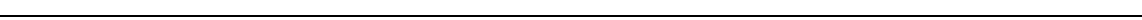
Fig. 5 iNKT cells suppress arthritis. a Representative fl ow cytometry plots of iNKT cells (TCR β int CD1d- α GC tetramer + in live CD8 − CD19 − cells), in ankles of SKG mice during the course of arthritis. Day 0 (circle), day 12 (square), day 22 (triangle), and day 47 (diamond) post-mannan injection. b Number of iNKT cells in ankles (left panel) and correlation with ankle swelling (right panel) during the course of arthritis in SKG mice. c Expression of CD69 on ankle iNKT cells during the course of arthritis in SKG mice. d Clinical score (left panel) and change in ankle thickness (right panel) in Cd1d − / − ( n = 6) and Cd1d + / − ( n = 8) male SKG mice after injection of mannan. e Histological evaluation of synovial in fl ammation (S), bone erosion (E), and cartilage destruction in arthritic ankles from Cd1d − / − ( n = 6) and Cd1d + / − ( n = 8) SKG mice. Scale bar 500 μ M. f Representative Micro-CT of ankles from arthritic Cd1d − / − and Cd1d + / − SKG mice. White arrow indicates bone erosion and reactive bone formation which is increased in CD1d − / − SKG mice. g Representative fl ow cytometry plots of iNKT (gated as in a ) cell depletion ef fi cacy in lymph nodes after injection with iNKT cell-depleting (NKT14) mAb. h Clinical score (left panel) and change in ankle thickness (right panel) in male SKG mice treated with NKT14mAb ( n = 5) or isotype control ( n = 6) after injection of mannan. Arrows indicate time of injection. i Histological evaluation of synovial in fl ammation (S), bone erosion (E), and cartilage depletion in male SKG mice treated with control or NKT14mAb. Scale bar 500 μ M. j , k Transfer of CD4 + SKG T cells (1×10 6 ) alone ( n = 7) or in combination with SKG iNKT cells (3×10 5 ) to Rag2 − / − mice ( n = 7) and the clinical score ( k , left panel) and change in ankle thickness ( k , right panel) after injection of mannan. Representative data from two independent representing individual mice. * p <0.05, ** p < 0.01 (Mann – Whitney on area under the curve ( d , h , k ), Mann – Whitney ( e , i ), One way ANOVA ( b , c ),